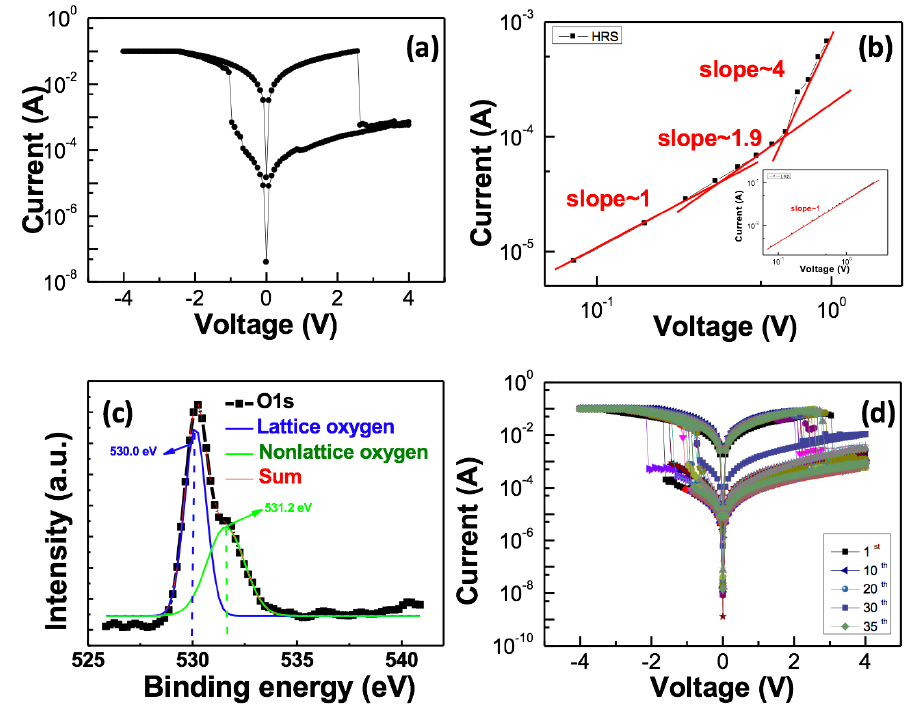
Figure 1. ( a ) I–V curves of the TiO 2 RRAM (resistive random access memory) device; ( b ) logI – logV characteristics for the switching mechanisms; ( c ) Displays the normalized XPS (X-ray photoelectron spectroscopy) spectra for O1s of the TiO 2 thin film; ( d ) Switching behavior of the TiO 2 RRAM device after 35 DC (direct current) sweep